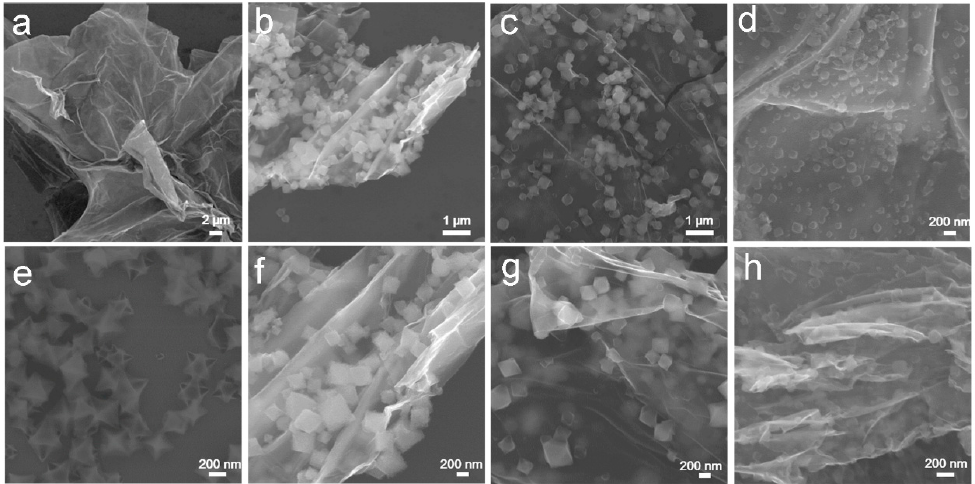
Figure 1. The scanning electron microscopy (SEM) images of ( a ) GO, ( b , f ) GO10-MIL-101(Fe) composite, ( c , g ) GO15-MIL-101(Fe) composite, ( d , h ) GO20-MIL-101(Fe) composite and ( e ) MIL-101(Fe).